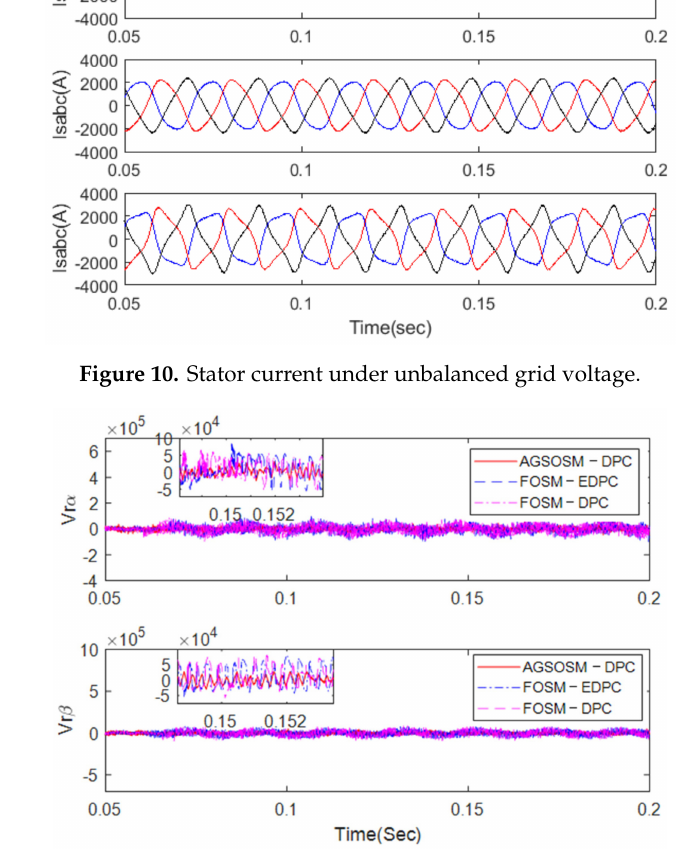
Figure 11. Control voltage under the proposed AGSOSM-DPC